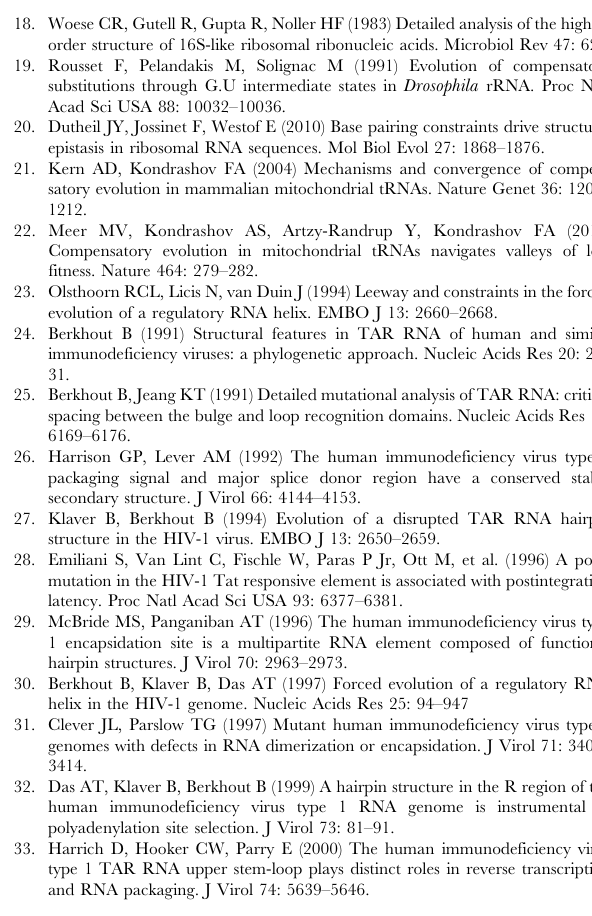
Figure S2 Intra-population frequencies of nonsynonymous second-site WC replacement polymorphisms in the HIV-1 genome. Frequencies are normalized to enable comparisons among classes (see Materials and Methods for details) and plotted on a log 10 -scale. Asterisks indicate p , 0.05 (*), p , 0.01 (**), and p , 0.001 (***). Table S1 Nucleotide replacement rates computed from replace- ments at nWC sites and from experimental mutation data of Mansky and Temin